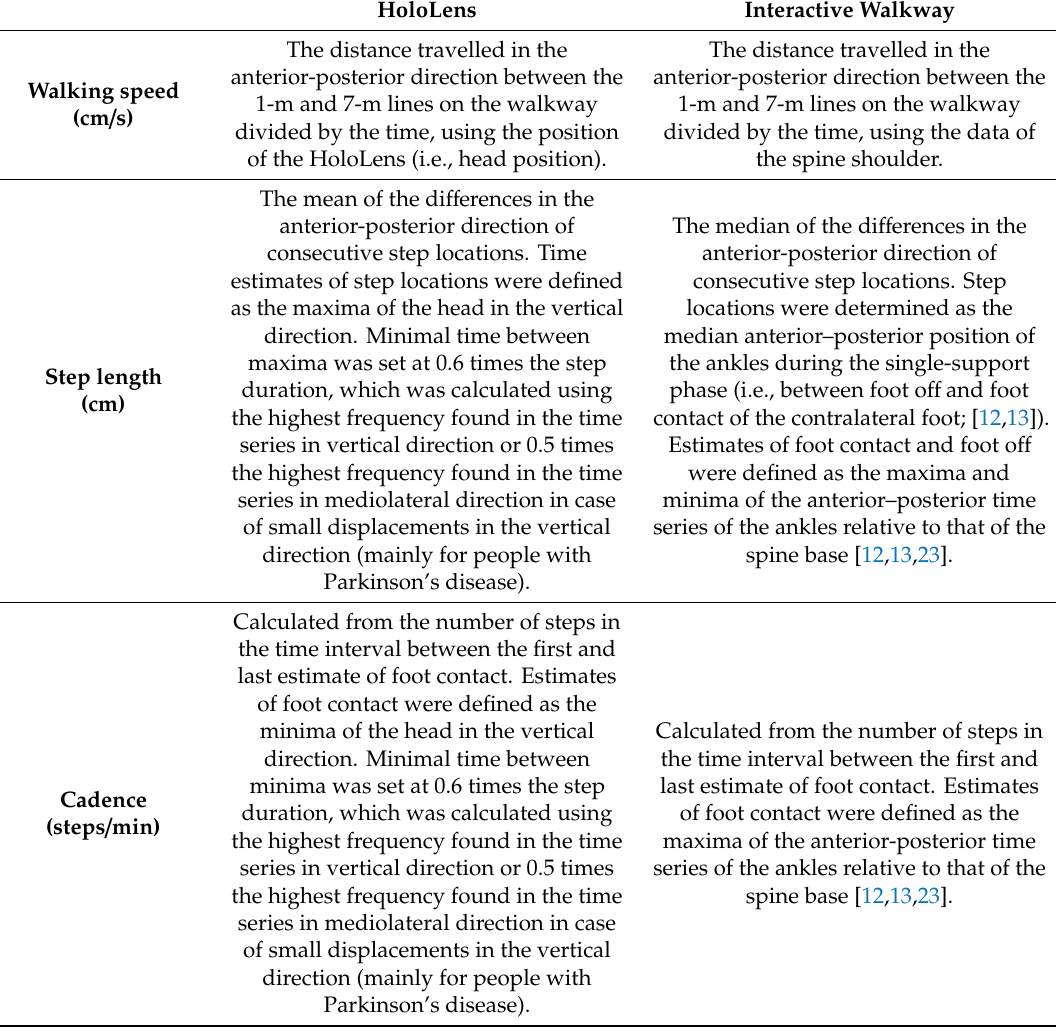
Table 1. Calculation methods of spatiotemporal gait parameters using HoloLens and Interactive Walkway position